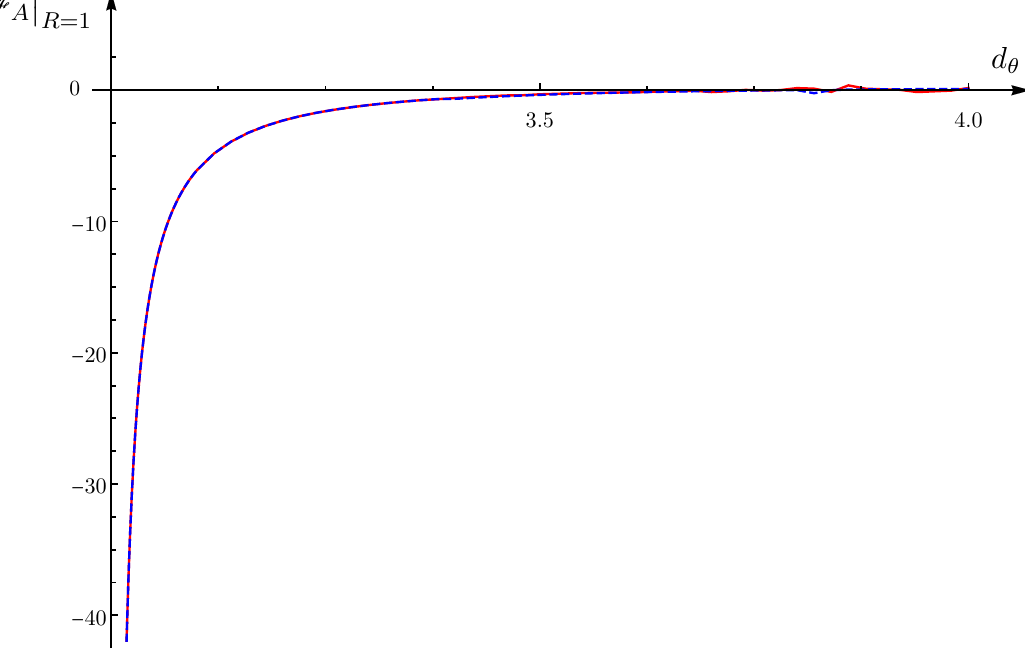
Figure 3 . Finite term F A in terms of 3 < d (cid:18) < 5 for minimal surfaces anchored to a disk of radius R = 1 in the hvLif 4 geometry (2.21) at t = const. The two curves have been obtained by (cid:12)rst solving numerically (with Wolfram Mathematica) the di(cid:11)erential equation (5.15) and then plugging the resulting pro(cid:12)le either in (5.18) (solid red line) or into (5.14) (dashed blue line), once the area law term has been